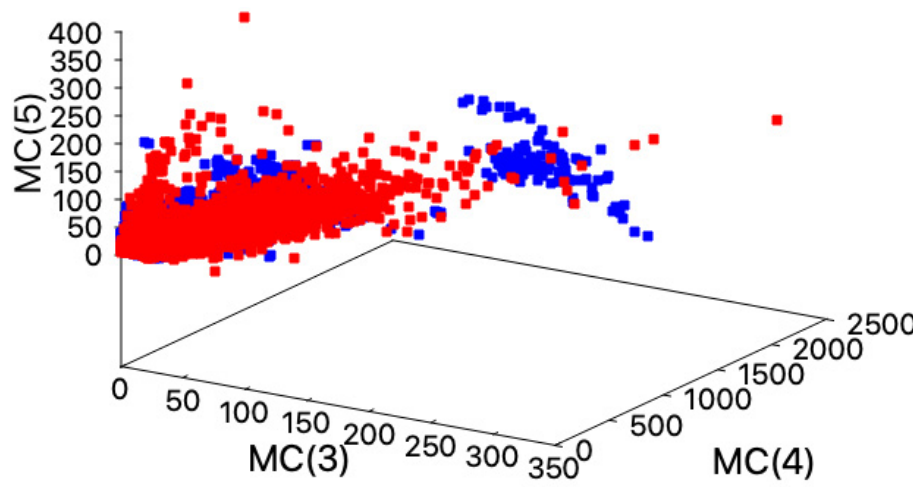
Figure 4. Maximal cliques observed in globular and transmembrane proteins. Protein structures were transformed into contact maps at 5 Å to identify the maximal cliques including 3, 4, or 5 residues using Tomita algorithm (see Methods); maximal cliques correspond with the protein regions where residues are highly packed. Maximal cliques occurrences of size 3, 4, and 5 (axis labeled MC(3), MC(4), and MC(5), respectively), are presented for both globular ( (cid:4) ) and transmembrane ( (cid:4) ) proteins. Please note the cumulus of blue squares on the right side of the image, which include the maximal cliques of size 3 that are accumulated in transmembrane